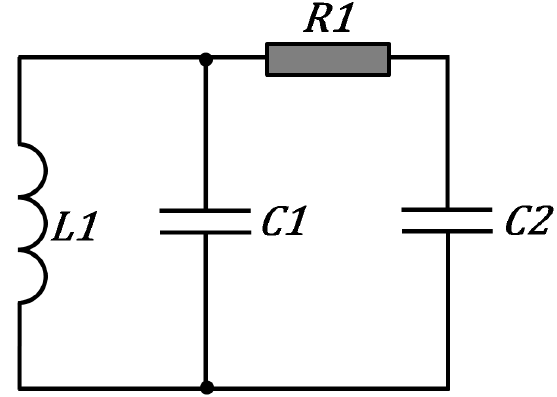
Figure 1. Electrical schematic of the Inductor-Capacitor-Capacitor-Resistor LCCR